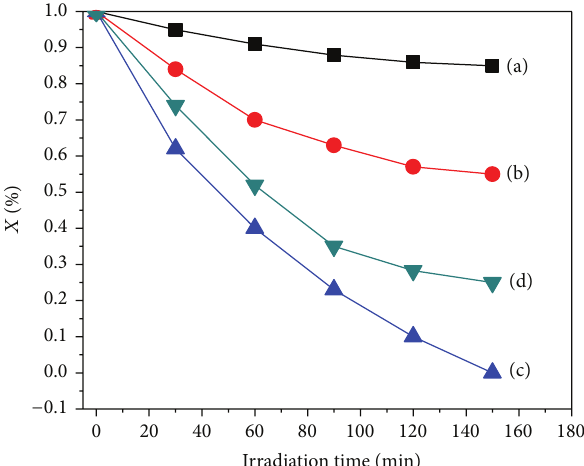
Figure 5: Comparison of the photocatalytic activity of the as-prepared samples for the degradation of OII under visible light irradiation: (a) carbon nitride; (b) CdS/CN-5; (c) CdS/CN-10; (d) CdS/CN-30.